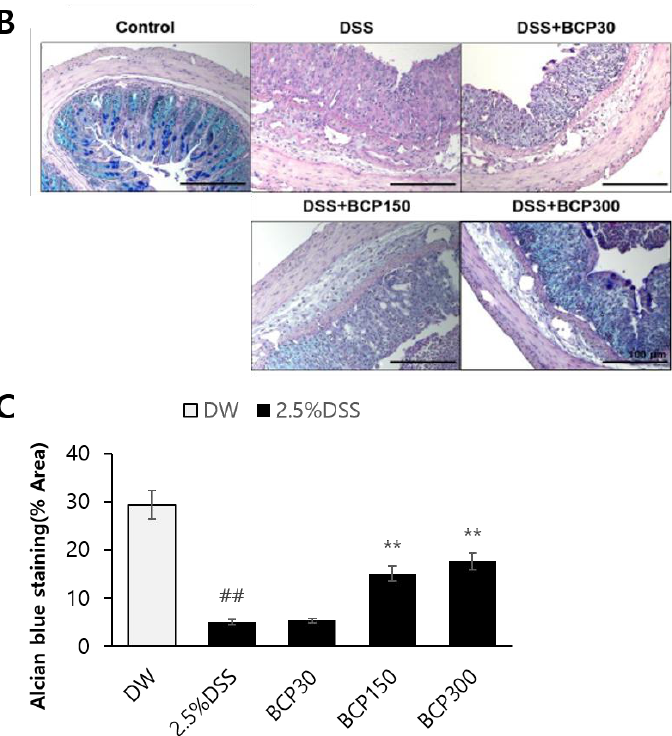
Figure 5. PAS-Alcian blue staining in mouse colons to evaluate changes in mucin in DSS-induced colitis model. The colonic tissure sections were observed at ( A ) 40 × and ( B ) 200 × magnification. PAS-Alcian blue staining was performed to compare ( C ) the contents of mucus in colons. Data are presented as mean ± SEM. Group comparisons were performed using unpaired t-test with post-test (##, p < 0.01, compared to vehicle-treated control mouse) (**, p < 0.01, compared to vehicle-treated, DSS-induced colitis mouse).